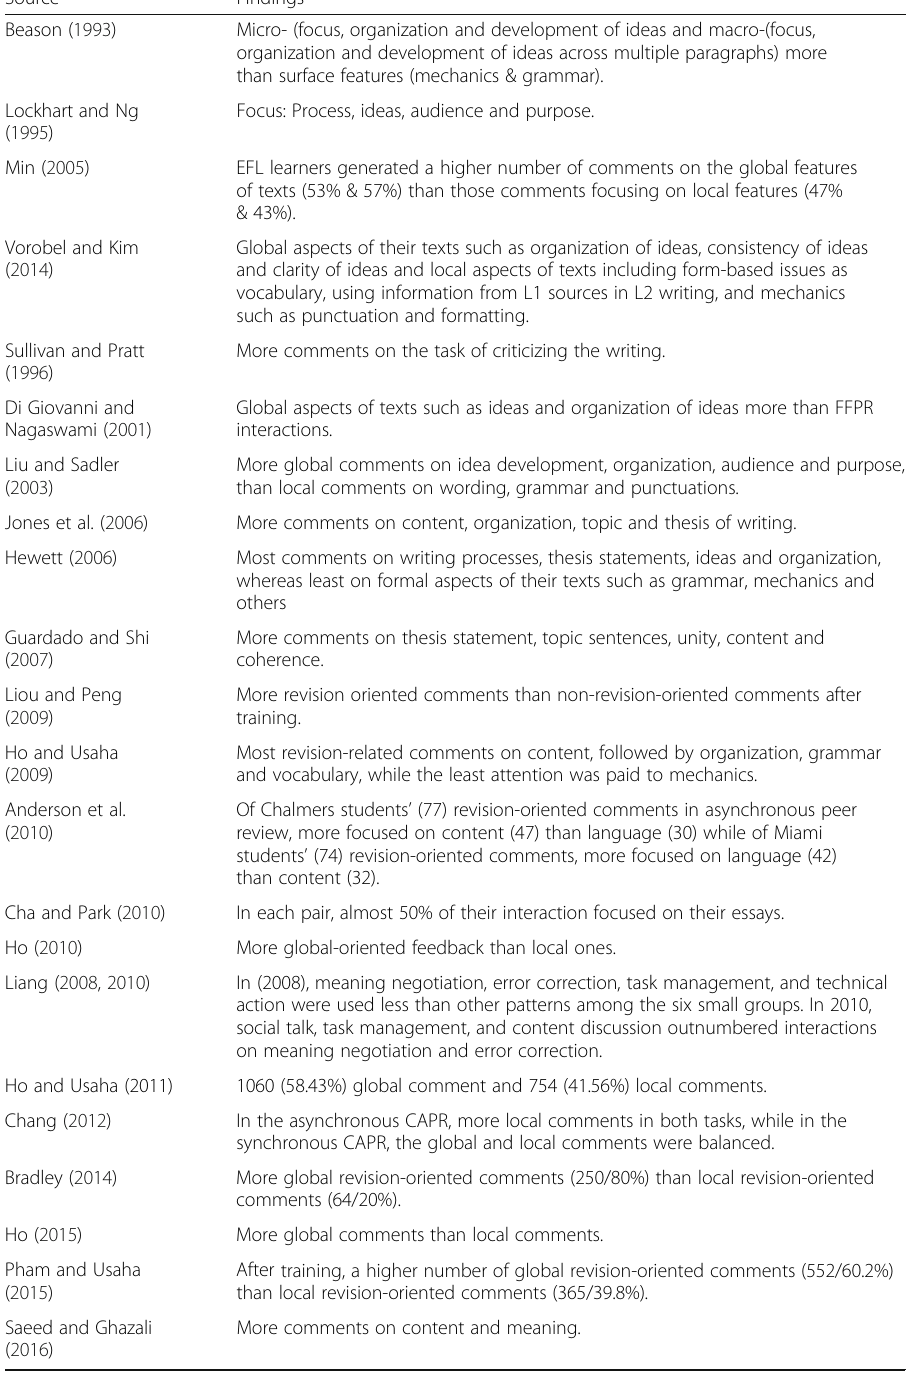
Table 3 A Summary of the Revision-Oriented Feedback Exchanges in FFPR and CAPR Source Findings Beason (1993) Micro- (focus, organization and development of ideas and macro-(focus, organization and development of ideas across multiple paragraphs) more than surface features (mechanics & grammar). Lockhart and Ng